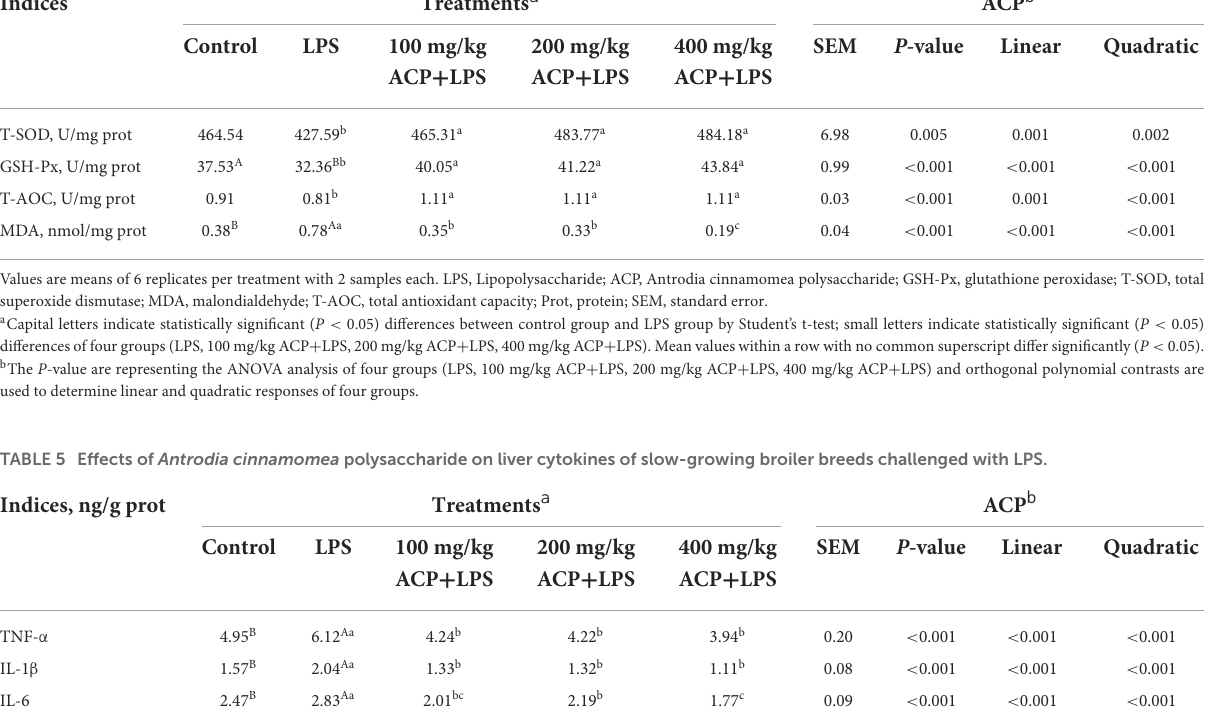
TABLE 4 Effects of Antrodia cinnamomea polysaccharide on liver antioxidant capacity of slow-growing broiler breeds challenged with LPS. Indices